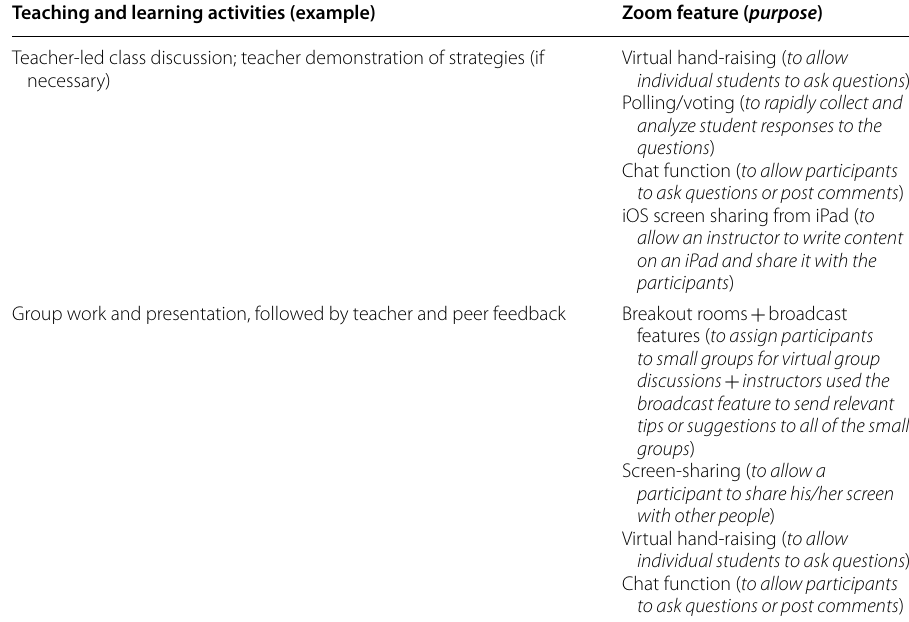
Table 5 Examples of Zoom features supporting the online flipped classroom Teaching and learning activities